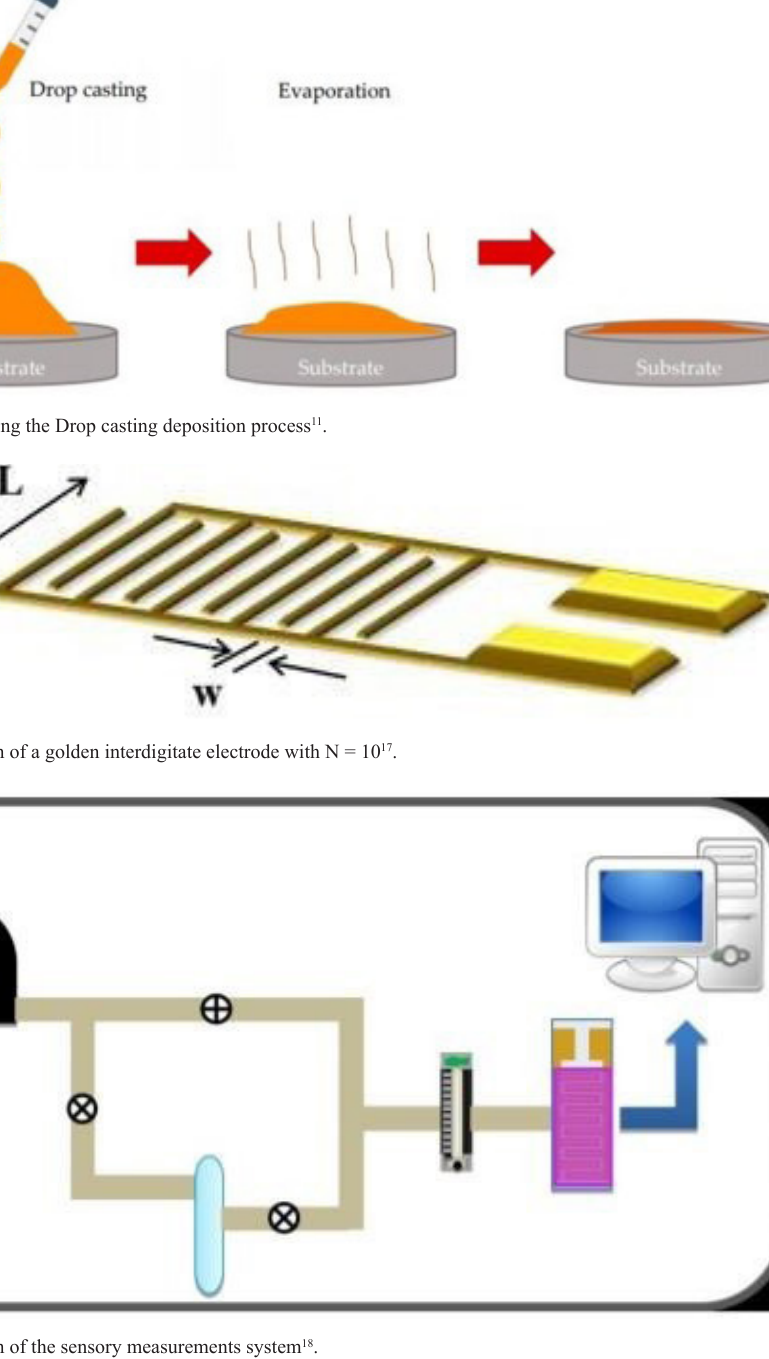
Figure 4. Representation of the sensory measurements system 18